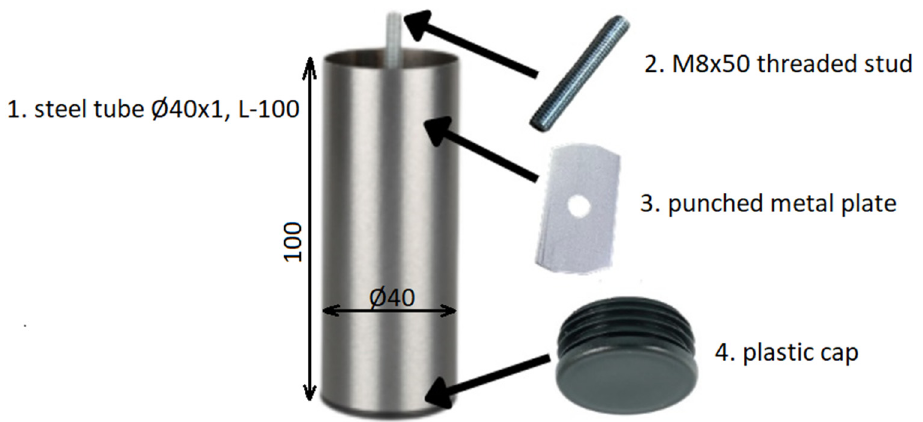
Figure 2. Steel metal furniture leg—D40 × L100 mm.